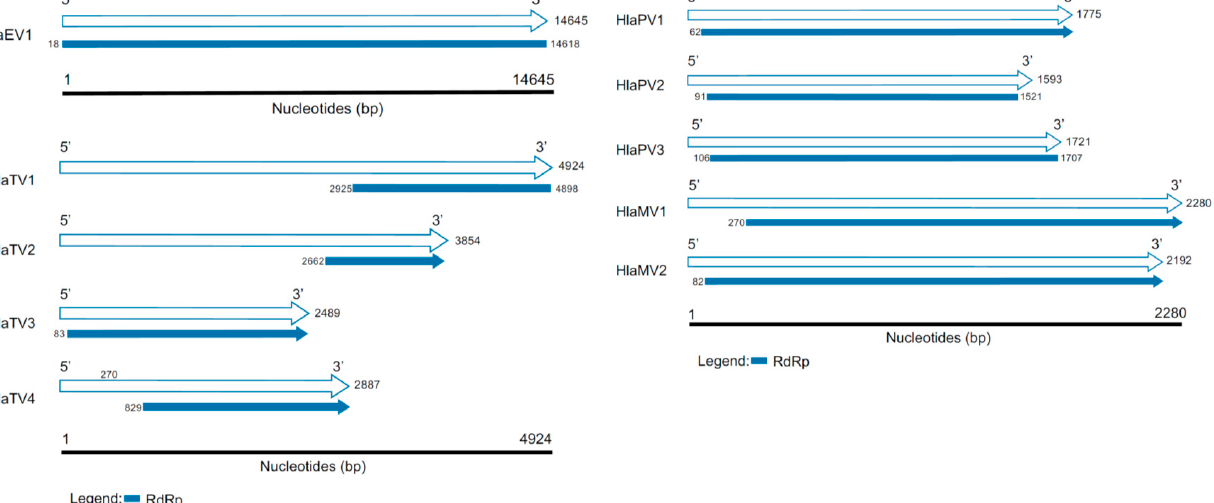
Figure 2. Genome organizations of the viruses discovered in this study. The white arrows represent the length of the contigs discovered in this study, and the RNA-dependent RNA polymerases (RdRps) are labeled in blue. The blue blunt ends represent complete RdRps, and the blue arrows indicate the RdRps are partial.